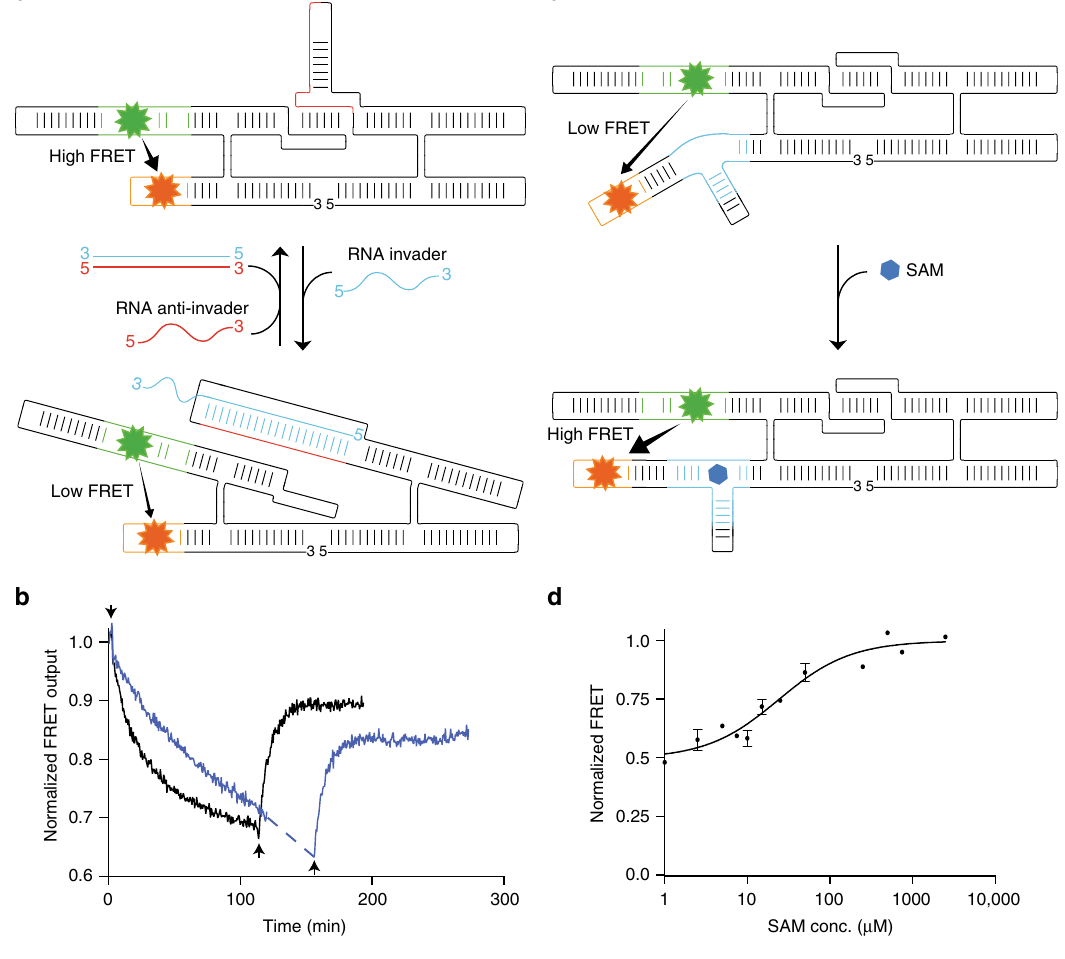
Fig. 3 Studying conformational changes using the apta-FRET system. a Secondary structure representation of an apta-FRET conformational switch containing Spinach (green), Mango (orange), and the KL extended with a hairpin, which has a seed sequence (red) that allows strand invasion of the KL by speci fi c RNA sequences (blue). b Time-resolved FRET measurements of the reversible invasion of the apta-FRET conformational switch with toehold extended invader RNAs and their anti-invaders. The arrow pointing down denotes the addition of toehold extended invader RNA and the arrows pointing up denote addition of anti-invaders. c The partially unstructured SAM riboswitch (light blue) in the apta-FRET SAM sensor causes a low FRET signal, when SAM (blue) is not present. Upon binding of SAM, the riboswitch motif transforms to a more structured conformation and the average distance between the fl uorophores in Spinach (green) and Mango (orange) is decreased, which results in an increased FRET signal. d Dose-response curve of the apta-FRET SAM sensor with an EC 50 of 17 µ M. Error bars indicate standard deviations ( n =